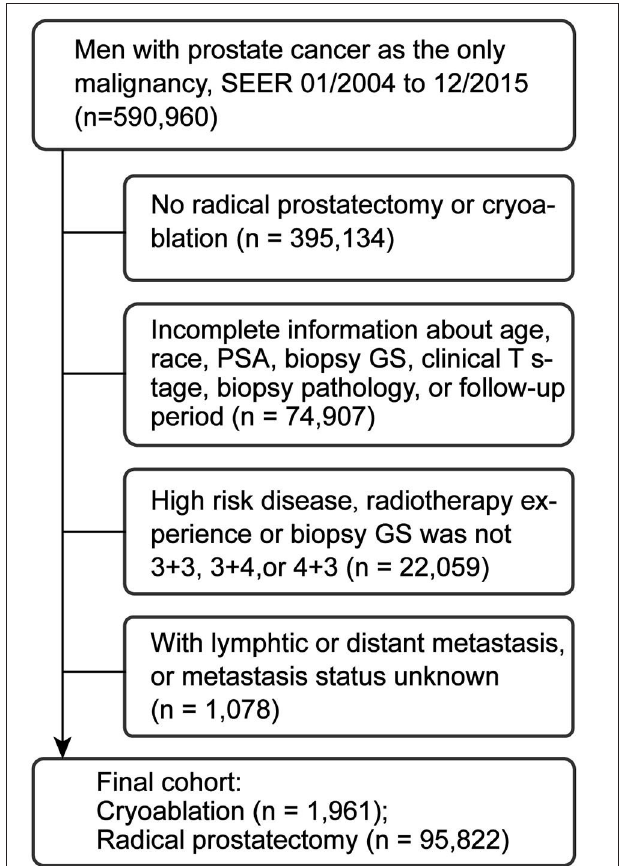
FIGURE 1 | Study cohort selection. PSA, prostate specific antigen; PCa, prostate cancer; SEER, surveillance, epidemiology, and end results database; GS, Gleason